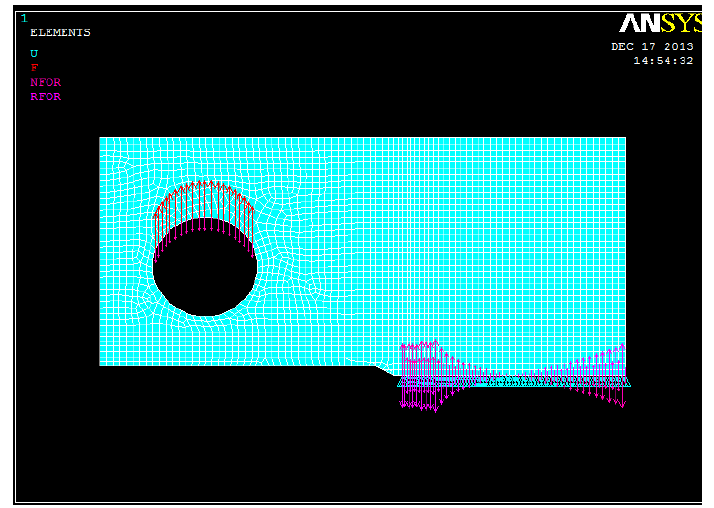
Figure 10: CT specimen mesh showing the loading and the symmetry boundary condition.